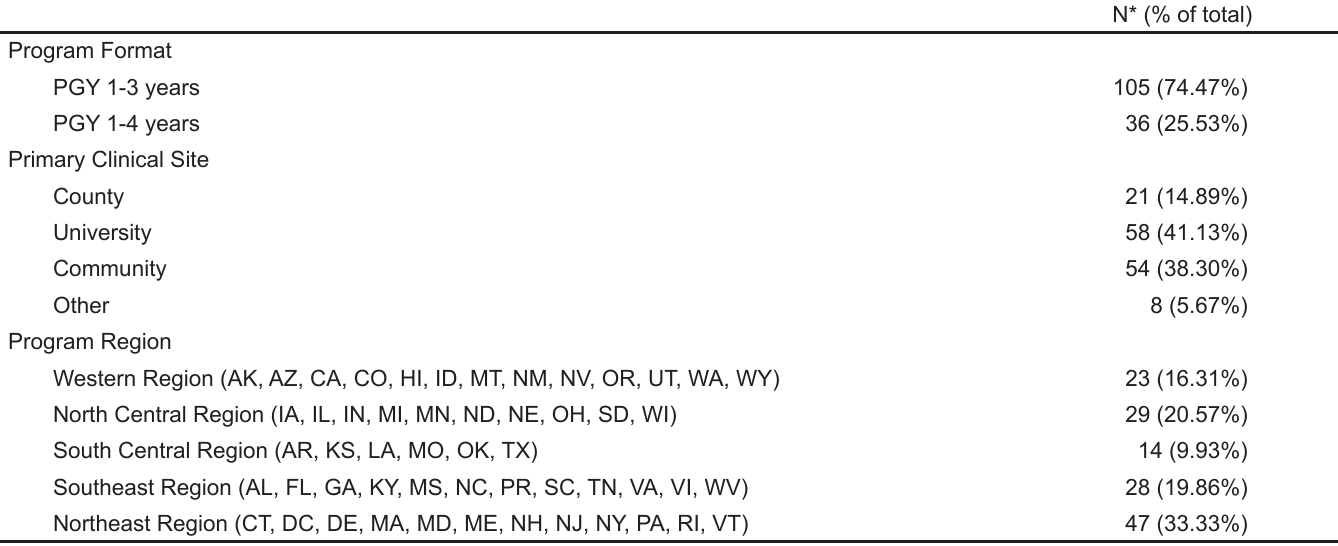
*1 respondent opted out of the demographic portion of the survey leaving 141 responses out of 142 responses. PGY, postgraduate